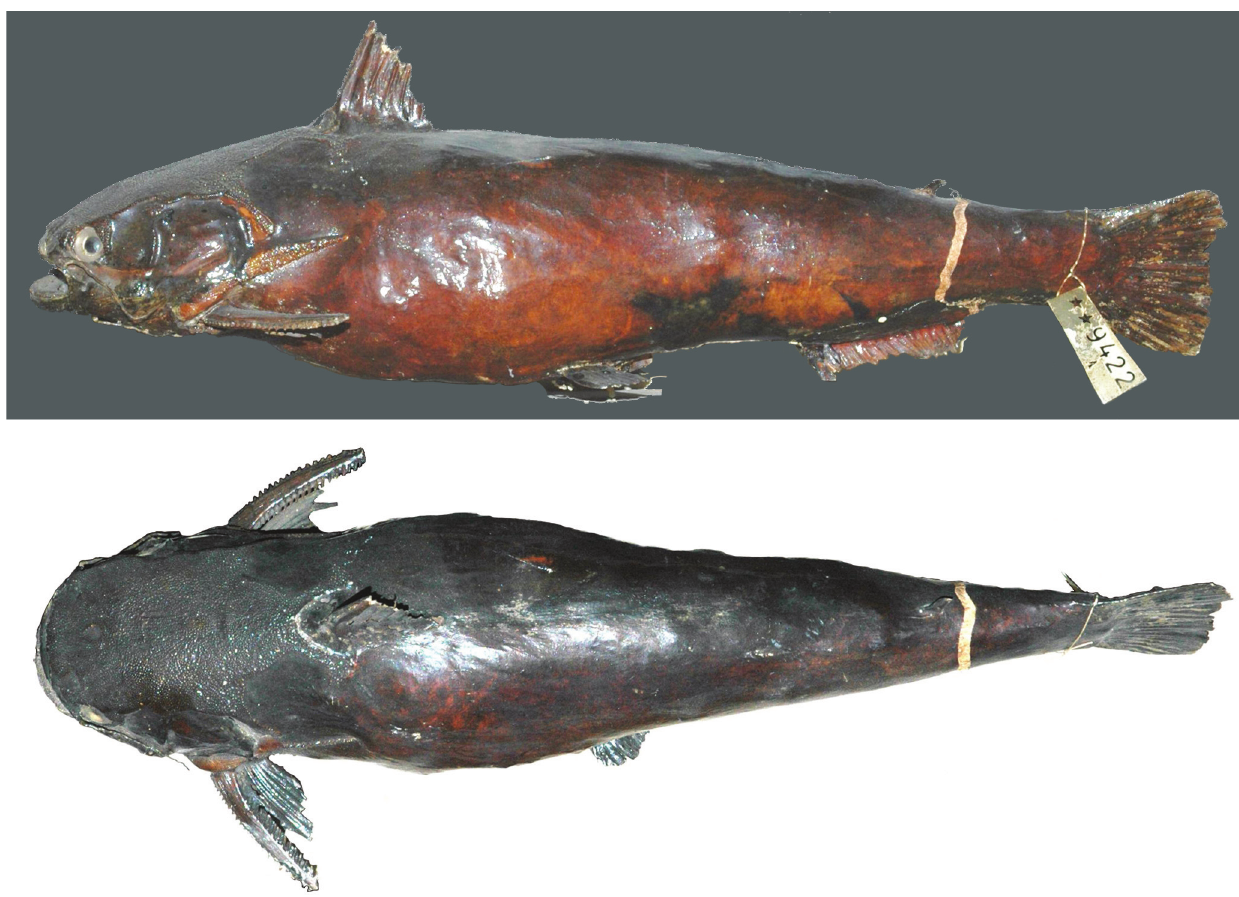
Fig. 4. Trachycotystes trachycorystes , MNHN A. 9422, holotype, 235 mm SL. Lateral